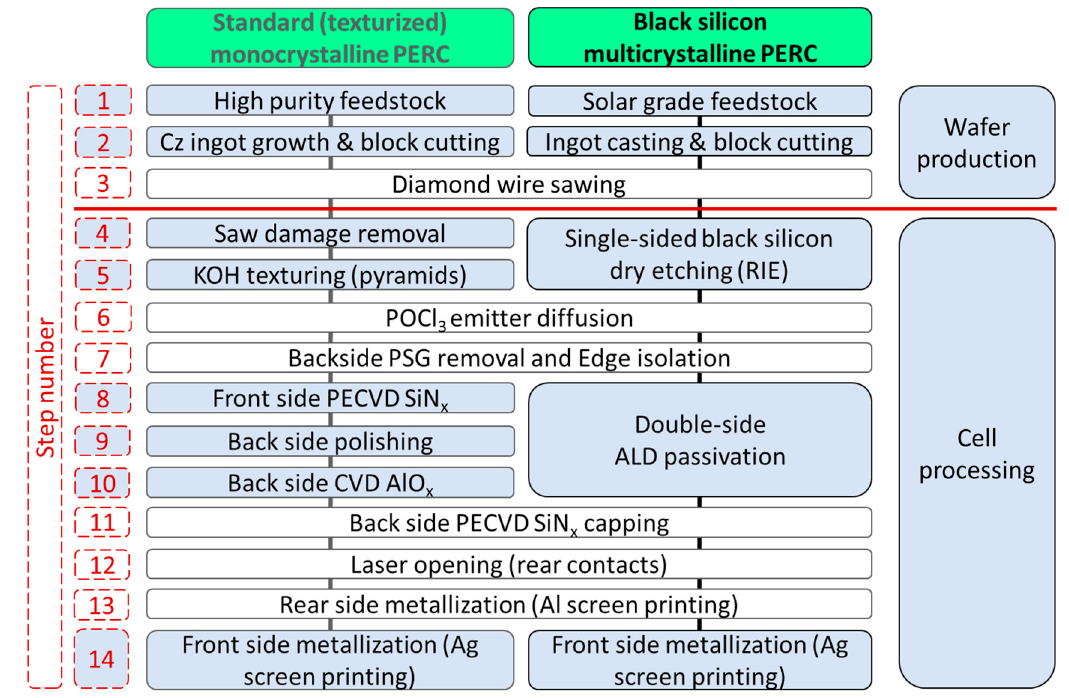
Figure 1. Detailed manufacturing steps for texturized Czochralski PERC cells ( left ) and multicrystalline black-Si PERC cells ( right ). The overall processes are divided into wafer production (Steps 1 to 3) and cell processing (Steps 4 to 14). Their cost represent 85% and 15% of the total costs for the texturized Czochralski and 82% and 18% for the multicrystalline black-Si PERC, respectively. The steps highlighted in blue differ for the two cell architectures and are considered in the cost calculations.